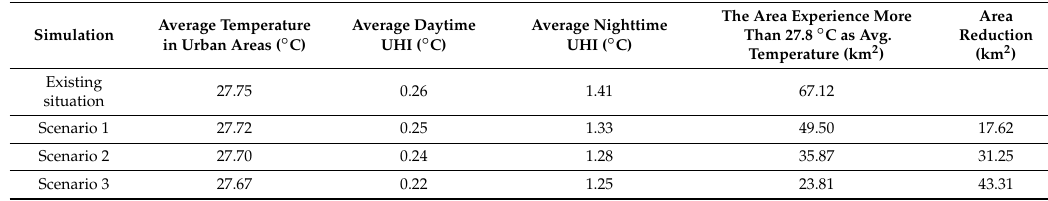
Table 2. Model’s outputs for greening scenarios.